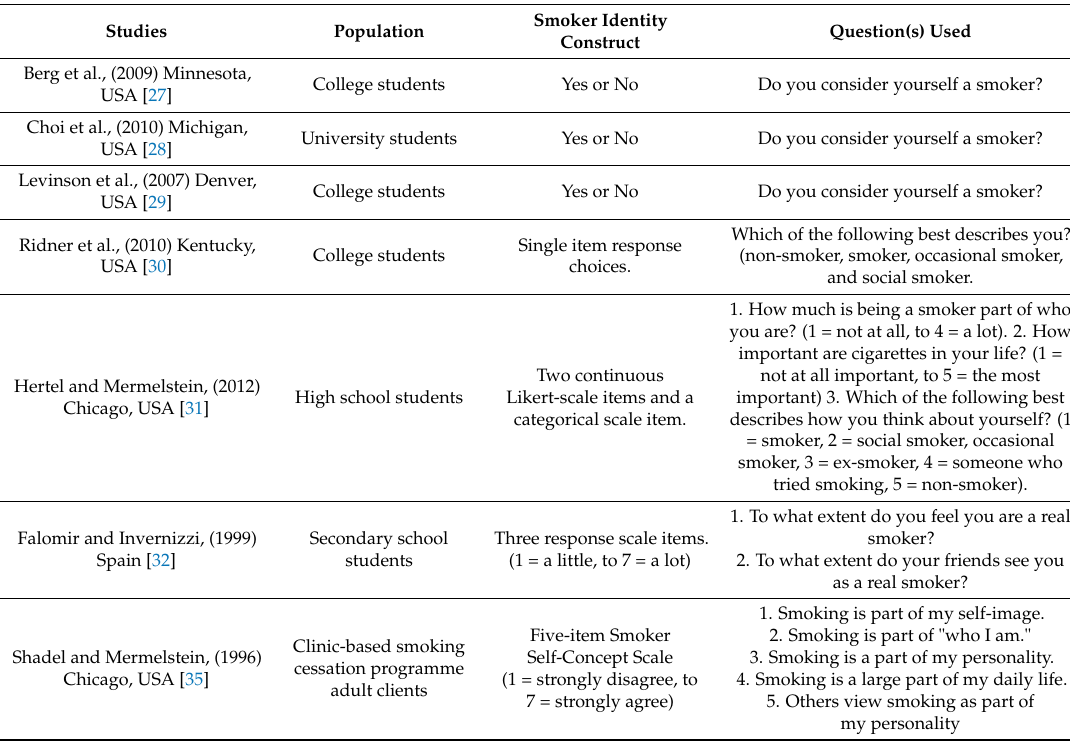
Table 1. Smoker identity construct measurements in